Question: What visual encoding does this figure use to show its data?
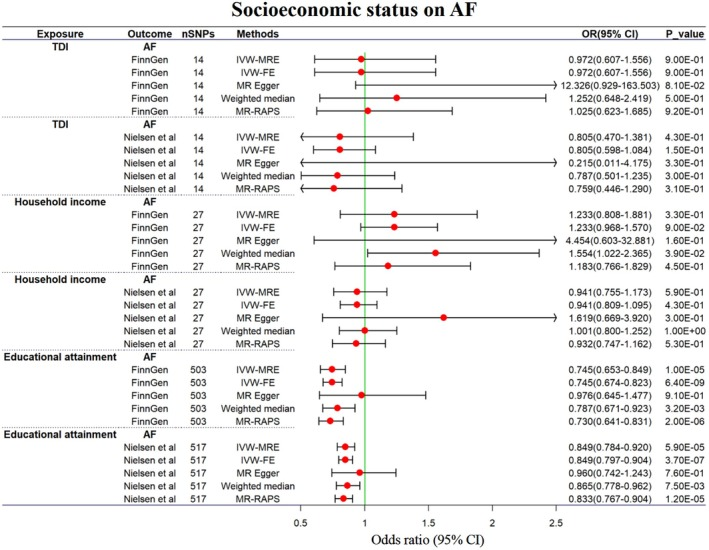
Answer: forest